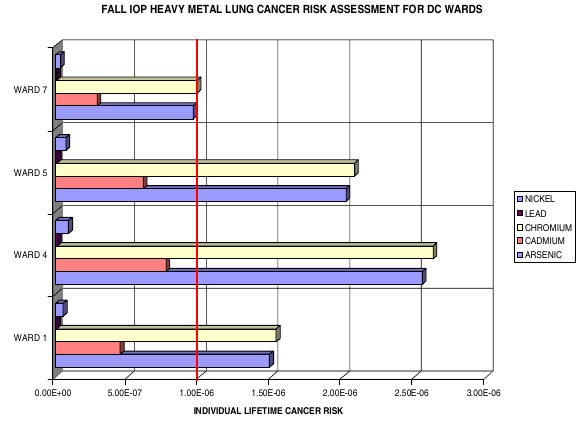
Figure 12: Summer IOP Lifetime Excess Lung Cancer Risk by DC